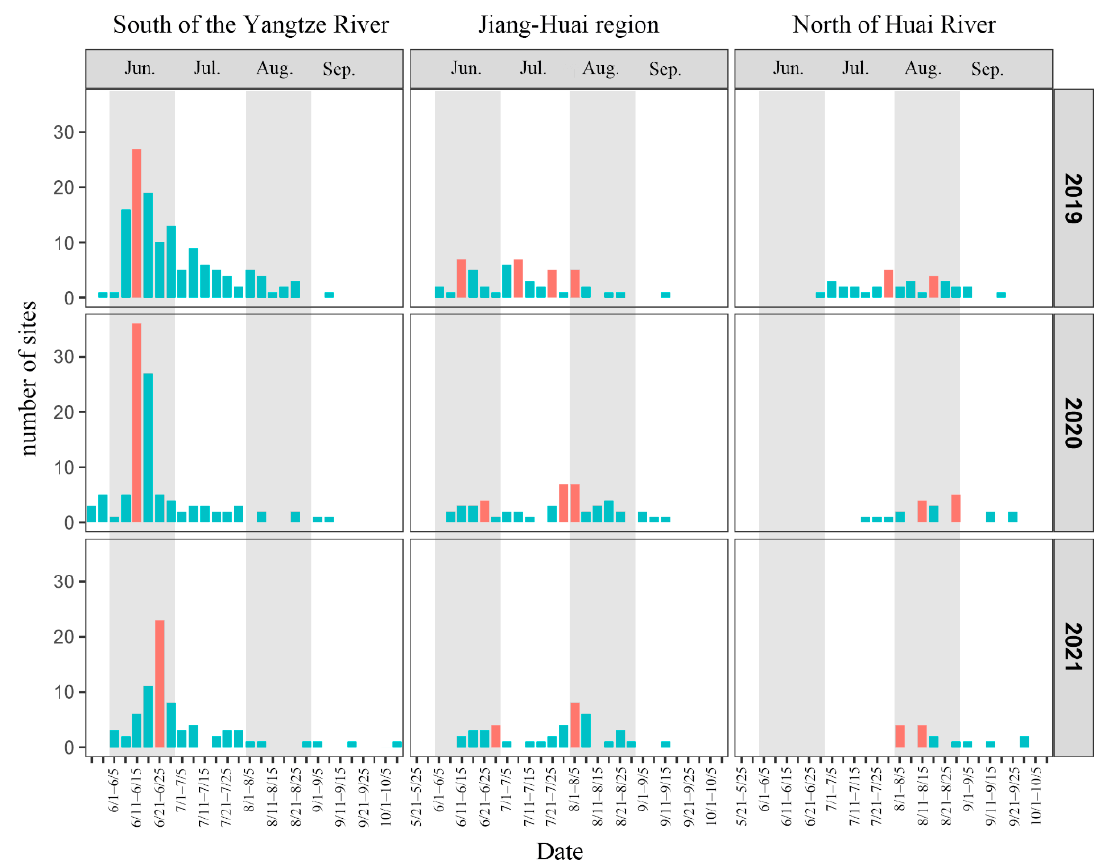
Figure 4. Eclosion time distribution of Spodoptera frugiperda in the Yangtze River Delta from 2019 to 2021. The red bar in the figure represents the eclosion peak.